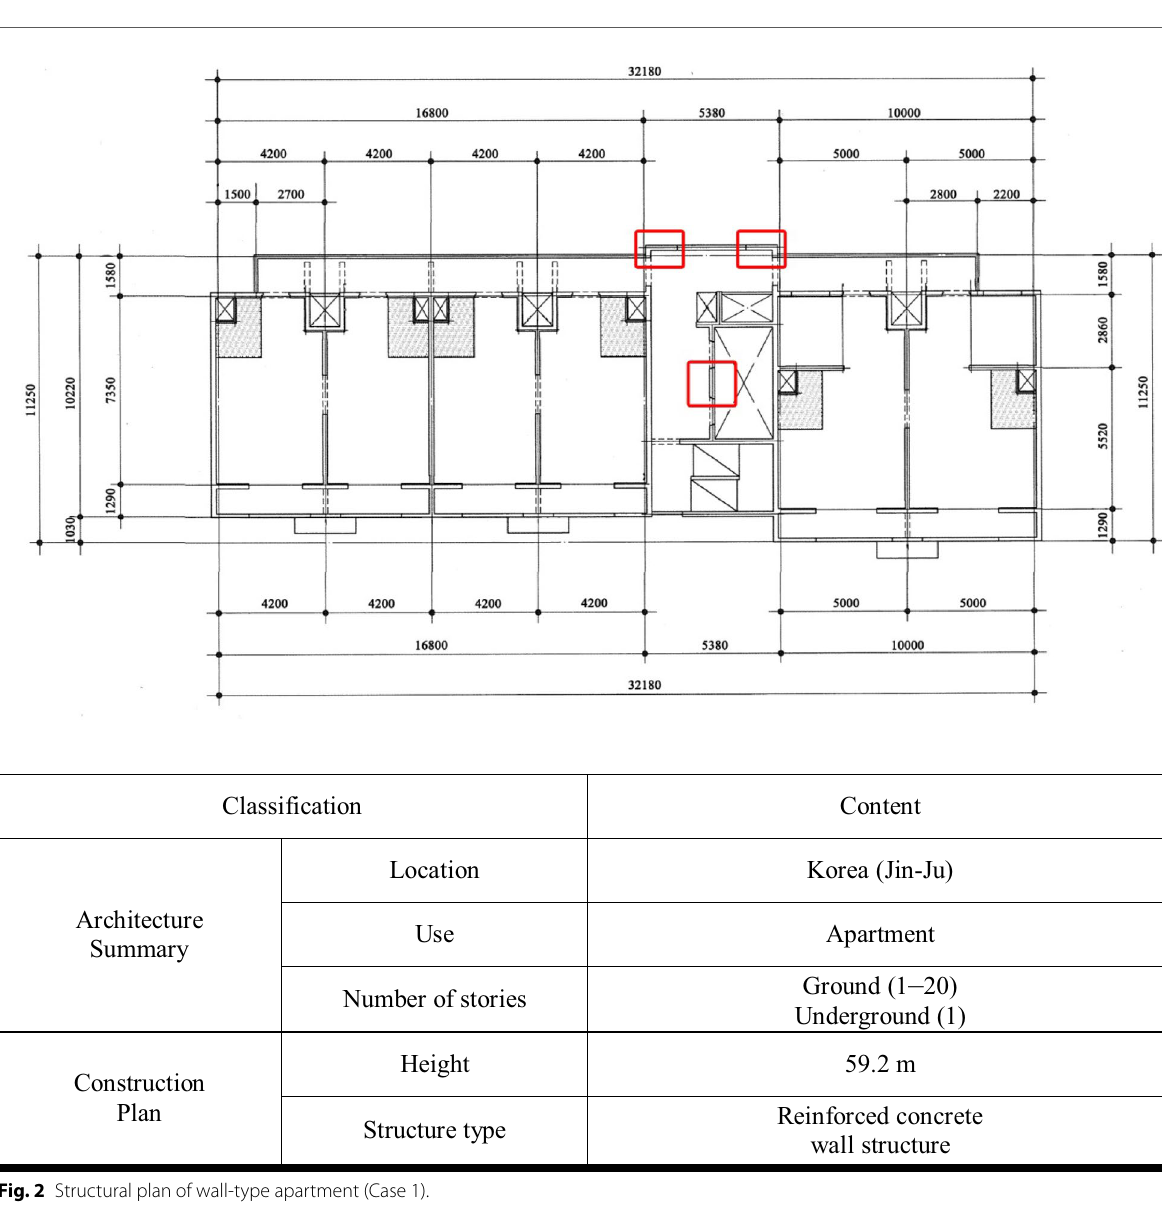
Fig. 2 Structural plan of wall‑type apartment (Case